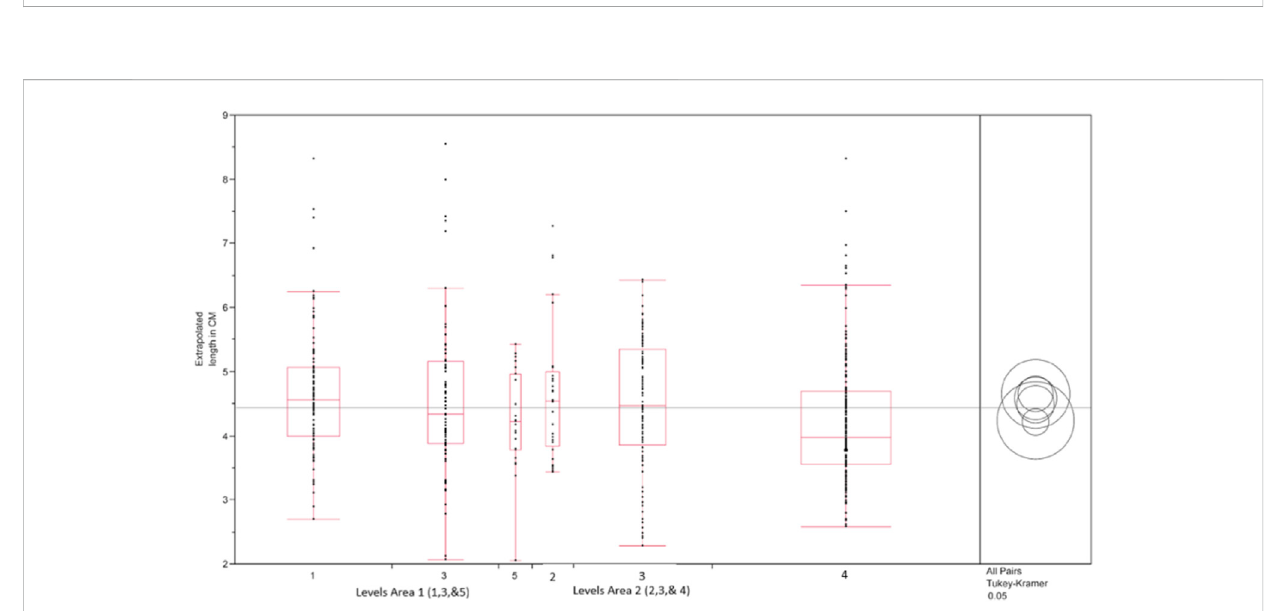
FIGURE 8 Mussel umbone data from CA-SMA-216. Data from Area 1 and 2. AMS Range 1300 CE-1640 CE. N = 796.